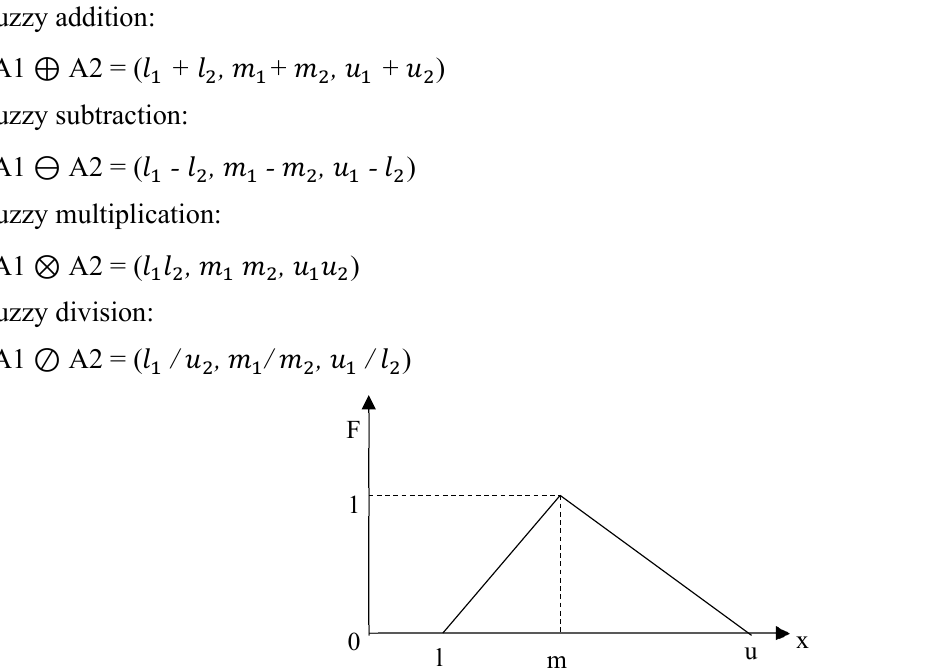
Fig. 1. Membership function of triangular fuzzy